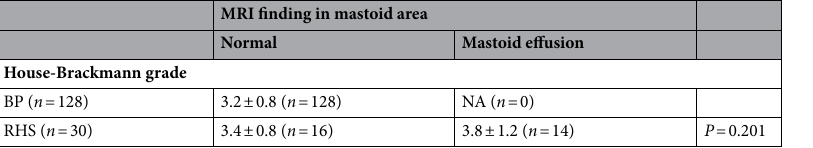
Table 3. Initial House-Brackmann grade according to magnetic resonance imaging (MRI) findings of the mastoid area in Bell’s palsy (BP) and Ramsay Hunt syndrome (RHS). NA, not